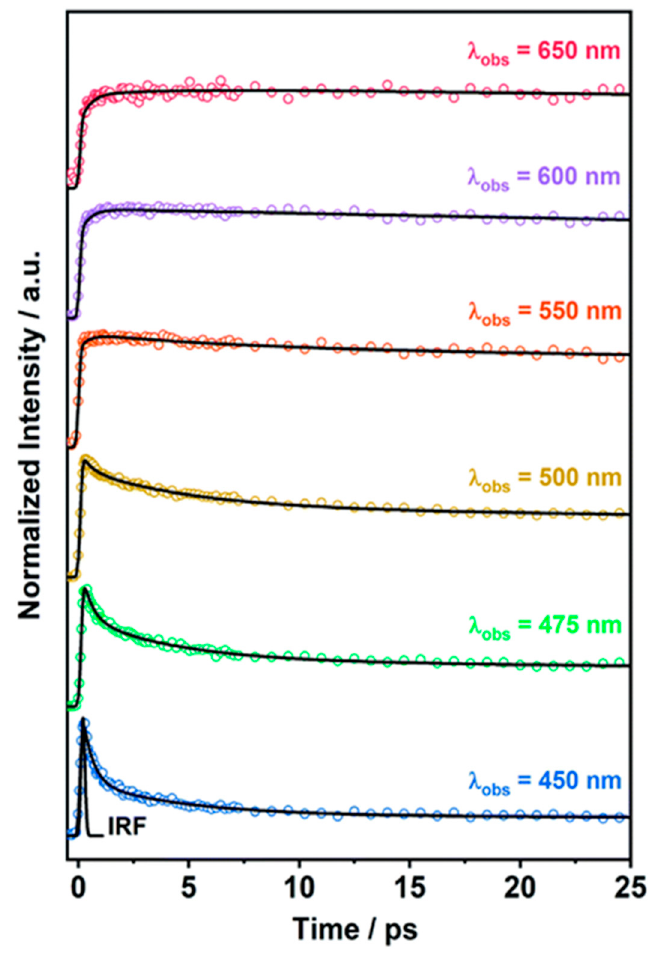
Figure 11. Fs-emission decays of ThiaHAT-1 in DMF suspension. The solid lines are from the best multiexponential global fit, and the IRF is the instrumental response function. This is an open access article under the CC BY-NC-ND license (http://creativecommons.org/licenses/by-nc-nd/4.0, accessed on 14 January 2022).